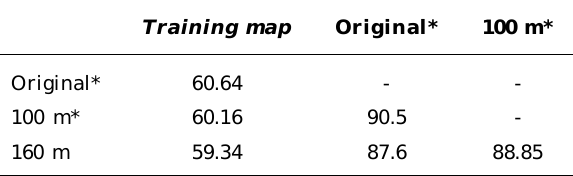
* The Haplic Acrisol (Profondic, greyic) [ACha2] soil class was not